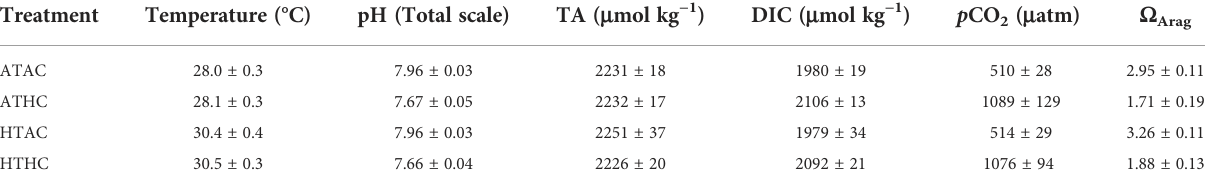
TABLE 1 Summary of (men ± SD) physical and chemical conditions for each treatment during the experiment.